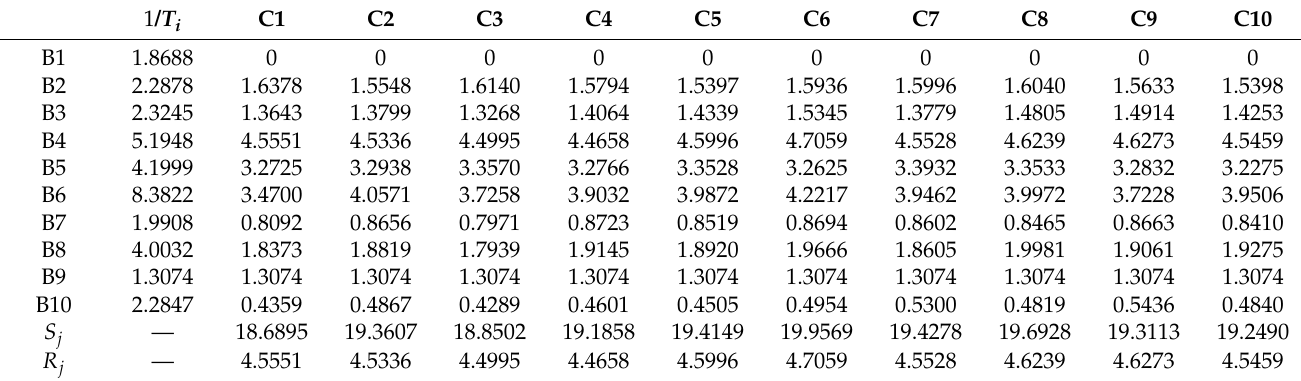
Table 18. The calculation results of group utility and individual regret.